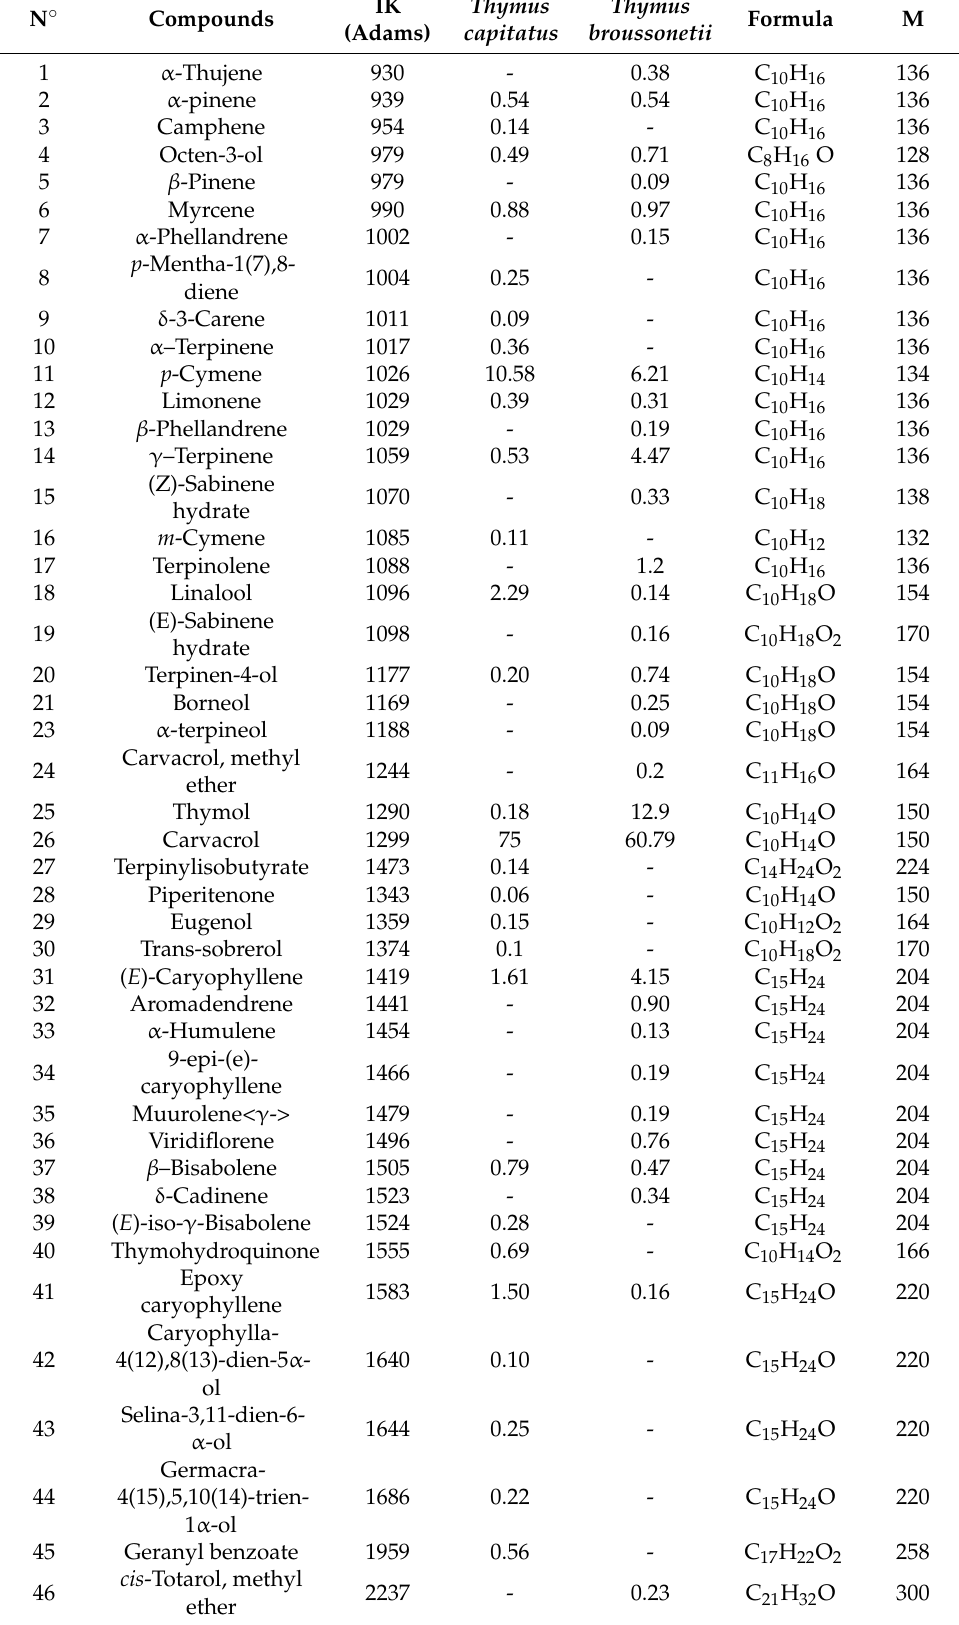
Table 1. Chemical composition of T. capitatus and T. broussonetii